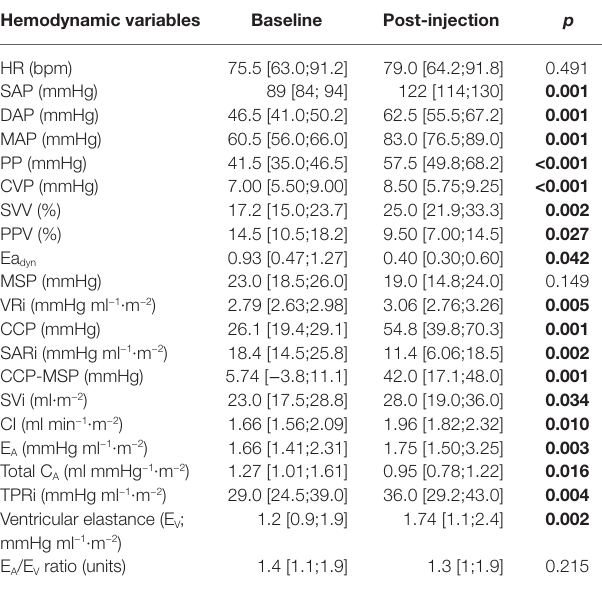
TABLE 2 | Comparison of hemodynamic parameters at baseline and after the norepinephrine injection. Hemodynamic variables Baseline